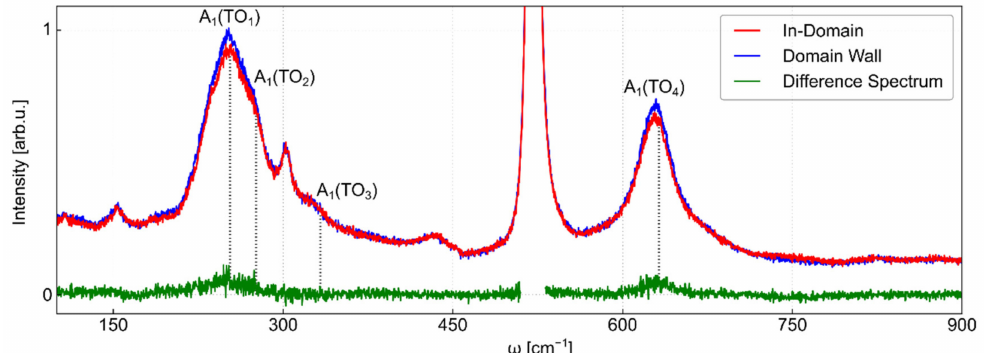
Figure 9. Comparison of Raman spectra taken inside a domain (red) and directly at the DW (blue) in x-cut TFLN on SiO 2 /Si in x(zz)-x geometry. The expected LN phonon peaks are marked in the figure. As seen in the different spectrum (green), the detected LN phonon modes A 1 (TO 1 ), A 1 (TO 2 ), and A 1 (TO 4 ) experience spectral changes between the domain walls and poled domains. Due to the small scattering volume of the thin film, the phonon peaks of the Si substrate form a strong